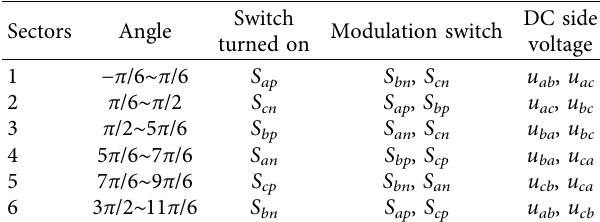
Figure 1: Topology of switching power supply based on H-bridge. Table 1: Switch states of rectifier